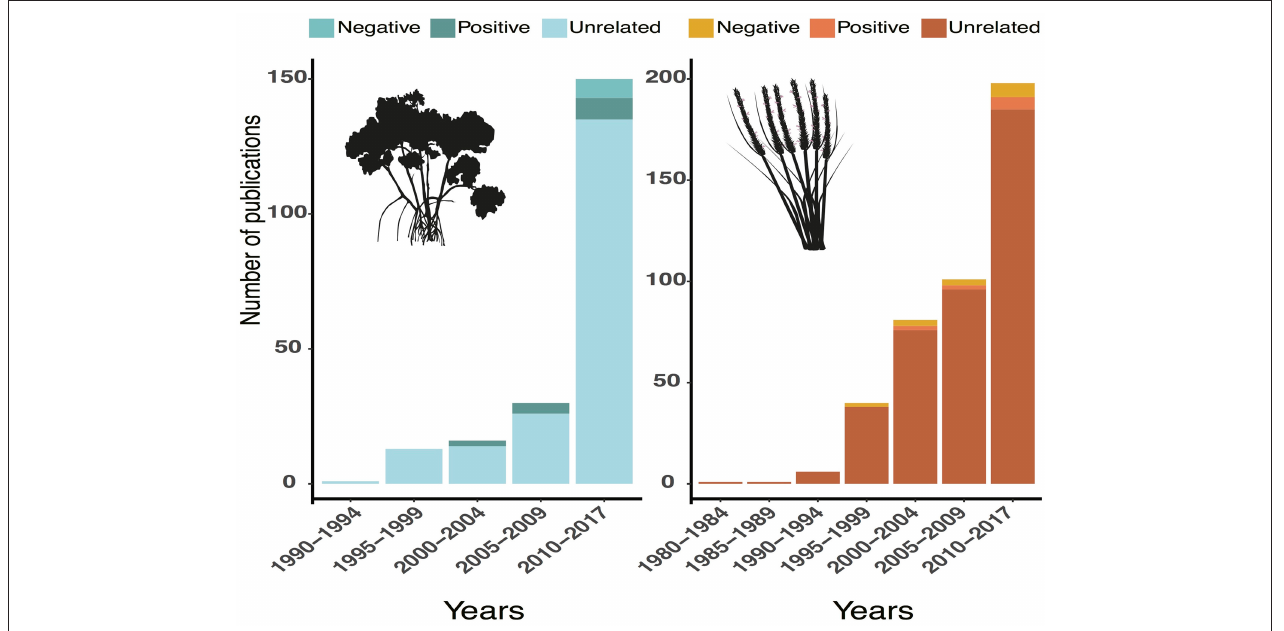
FIGURE 4 | Results from a Web of Science literature review for articles about salt-marsh and mangrove restoration from 1980 to 2017. See acknowledgments for vector credits.